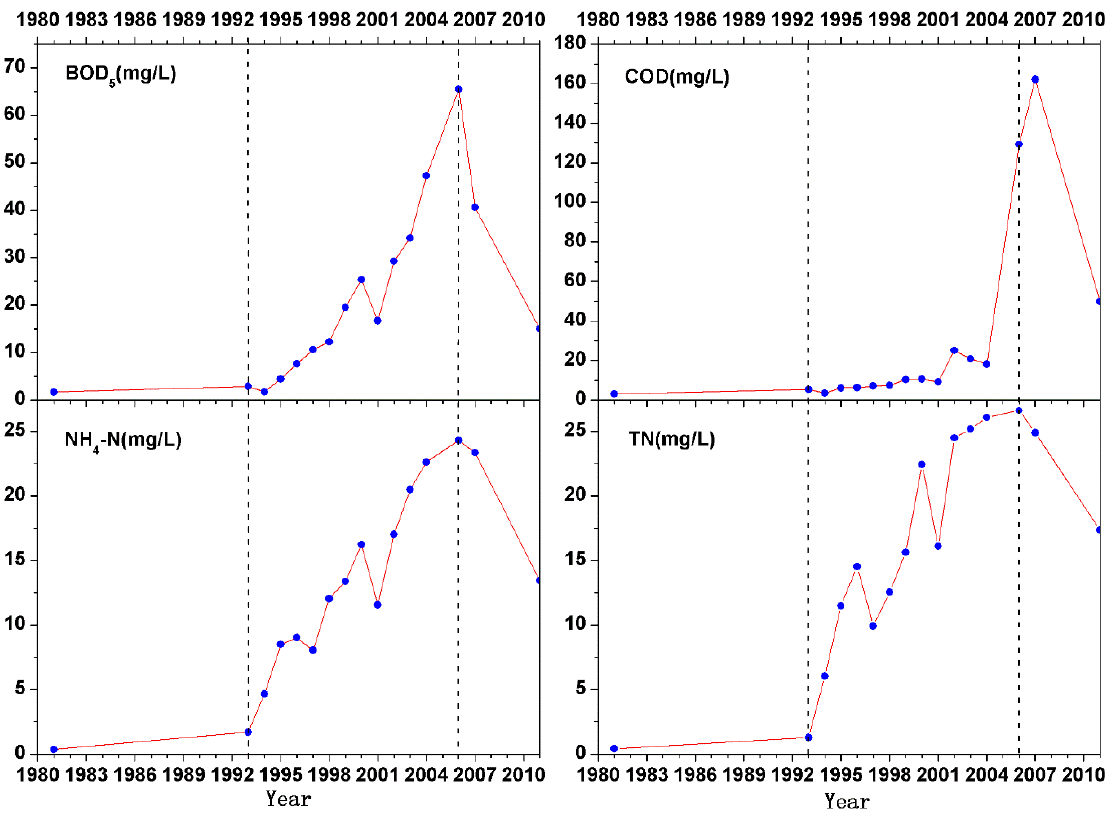
Figure 2. Thirty-year changes in water quality in the Guanlan River. The data from 1981 to 2006 were collected from the literature [18–23]. The 2011 data were obtained from the